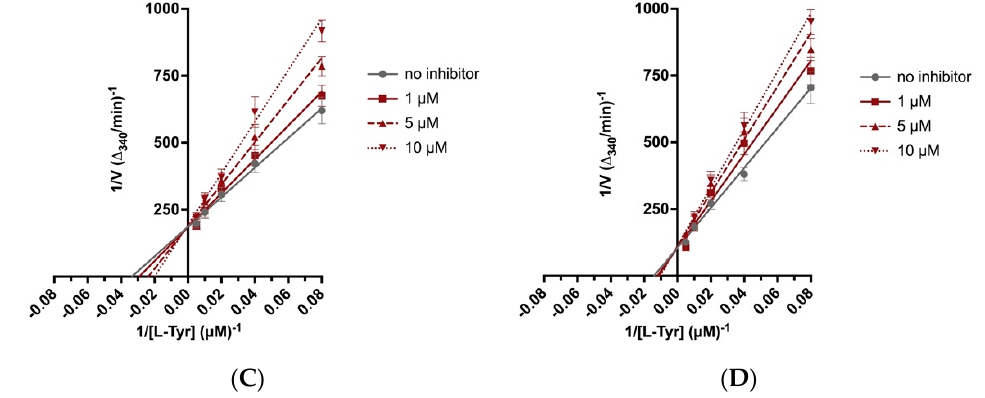
Figure 3. Lineweaver–Burk linearized plots with varying concentrations of compounds 2a and 6a . The concentration of inhibitor varied from 0 to 10 µM. As a substrate, L-tyrosine (L-Tyr) was used with 0.125, 0.25, 0.5, 1, and 2 mM concentrations. V—reaction rate. ( A ) AAH1 and 2a as inhibitors. ( B ) AAH2 and 2a as inhibitors. ( C ) AAH1 and 6a as inhibitors. ( D ) AAH2 and 6a as inhibitors. Each point represents the combined averages of three independent experiments in triplicate under the same conditions. Table 2. Kinetic parameters of the AAH1 and AAH2 inhibition assays of compounds 2a and 6a .